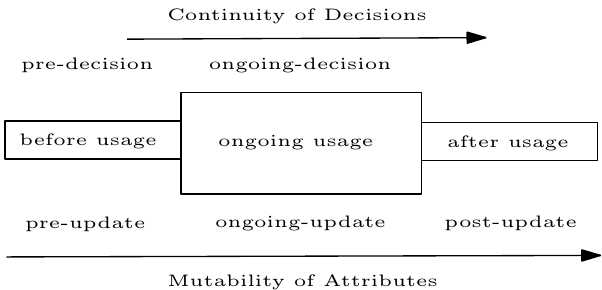
Figure 2. Continuity and mutability properties of